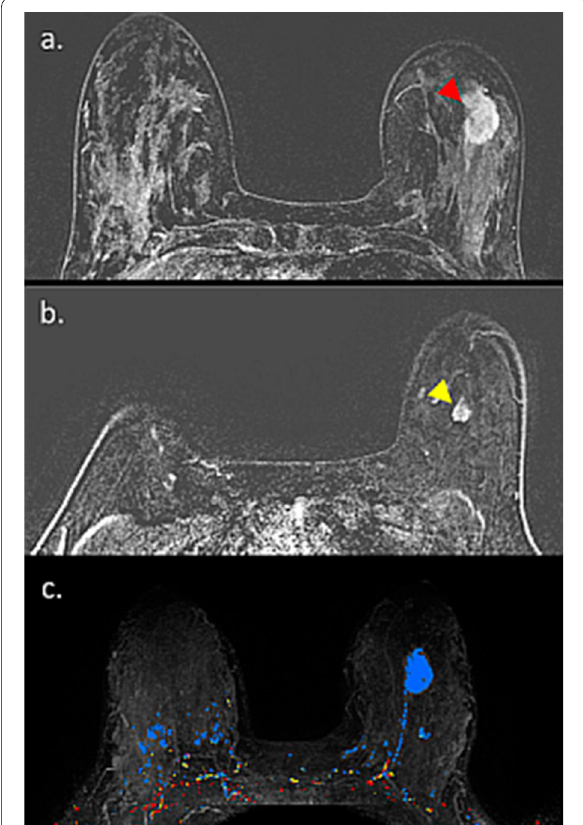
Fig. 14 MRI of a complicated case of IDC with lactation changes. Axial subtracted DCE‑MRI and CAD of lactating patient with newly diagnosed PABC, undergoing preoperative evaluation are shown. The tumor, 2.8 cm IDC in the left breast, is well visible on top of the surrounding BPE ( a ). Yet, additional ipsi‑lateral enhancing 0.9 cm lesion is apparent ( b ). Upon focused US and US‑guided biopsy, the second lesion came up to be adenosis and lactating changes on pathology. Interestingly, CAD depicted both lesions, as well as slight BPE in blue color, which corresponds to persistence wash‑in pattern which usually represents a benign pattern ( c